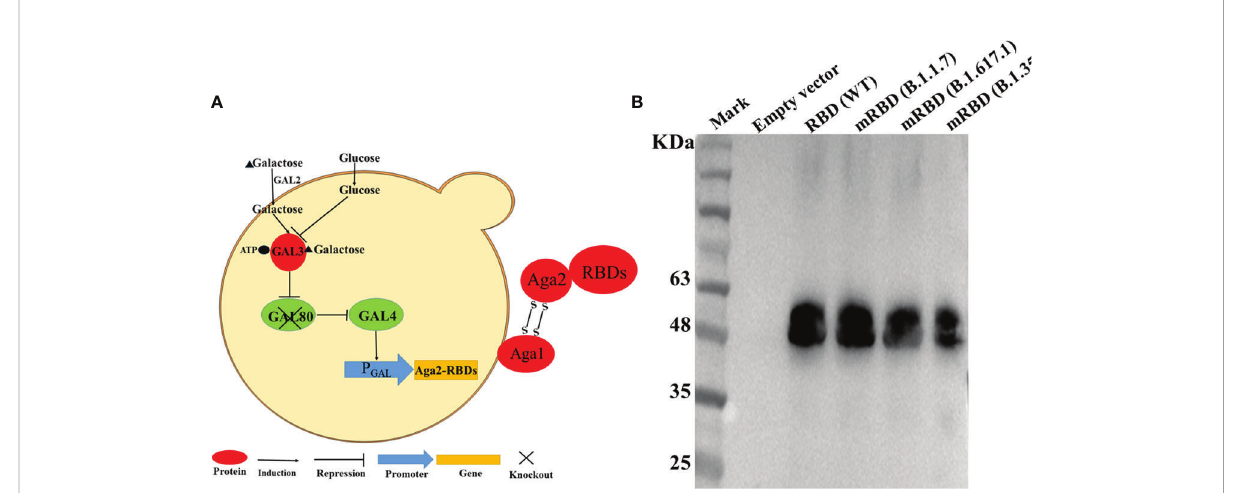
FIGURE 1 RBD displayed on the S . cerevisiae surface. (A) Schematic illustration of RBD displayed on the yeast surface. (B) Western blotting analysis of RBD and its mutant variants expressed on the surface of S . cerevisiae